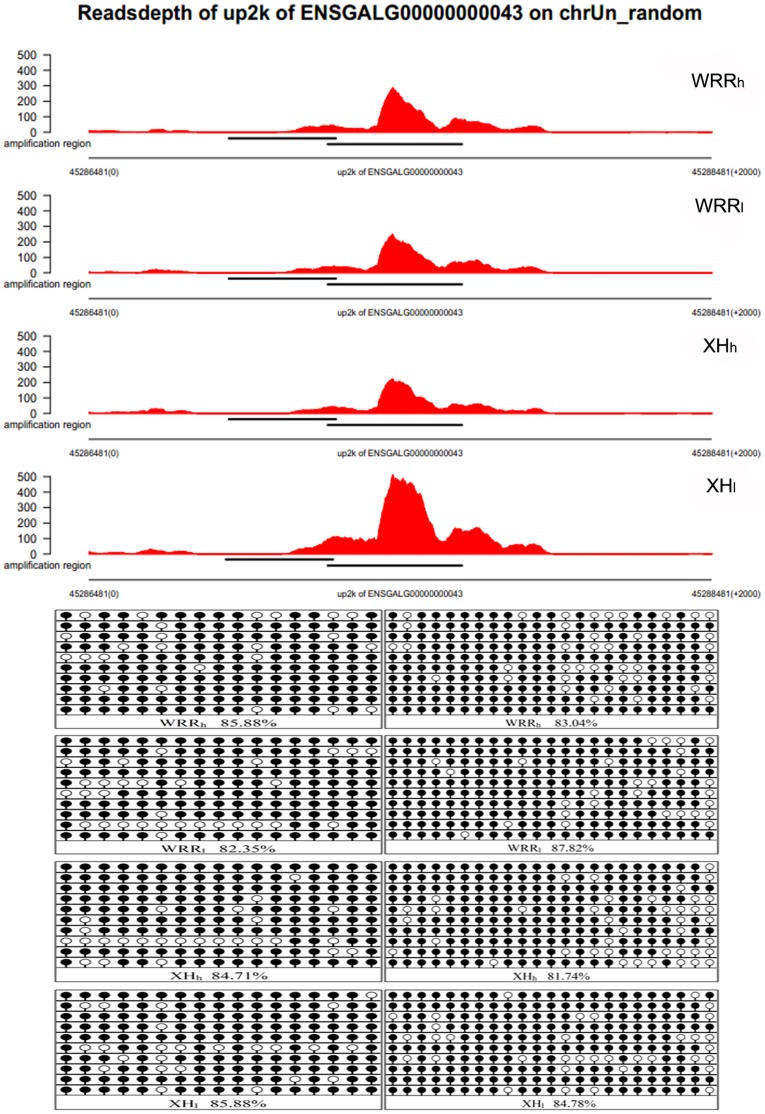
The validation of MeDIP-seq data by bisulfite sequencing.One region with high methylation obtained from MeDIP-Seq data was selected and its methylation pattern was assessed by bisulfite sequencing. Each line corresponded to a single strand of DNA and each circle represented a single CpG dinucleotide. Filled circles and open circles indicated methylated sites and unmethylated sites, respectively.